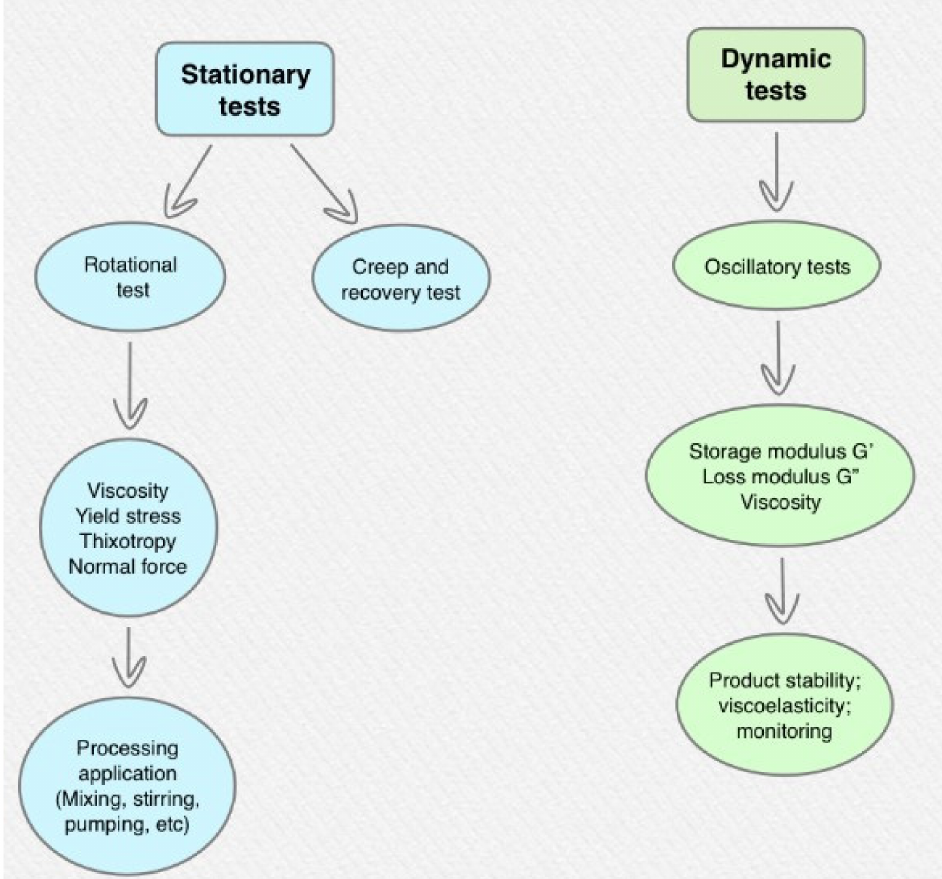
Figure 2. Rheological tests used in food characterization